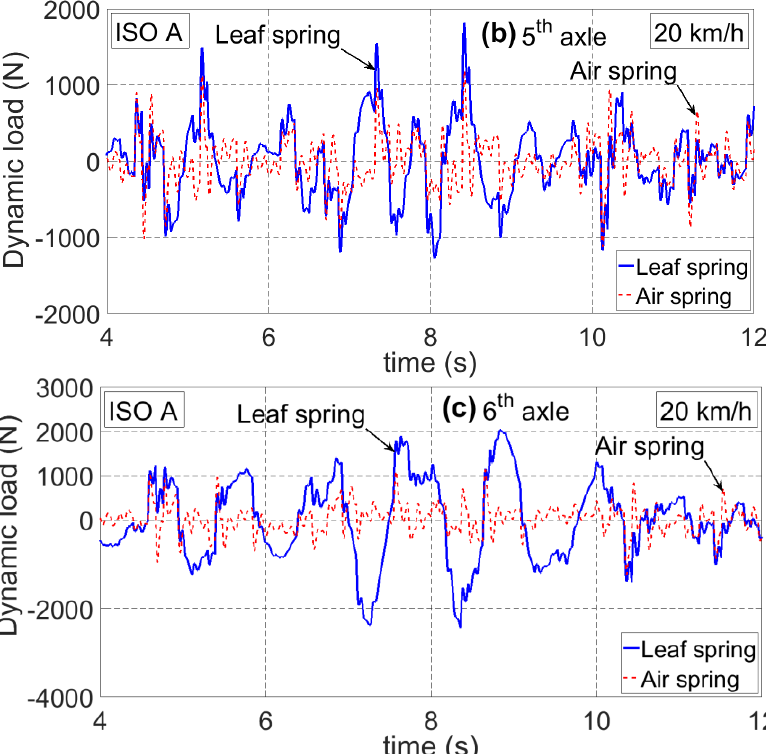
Figure 11. Responses to time domain of the dynamic load: ( a ) at the 4th axle, ( b ) at the 5th axle, ( c ) at the 6th axle.